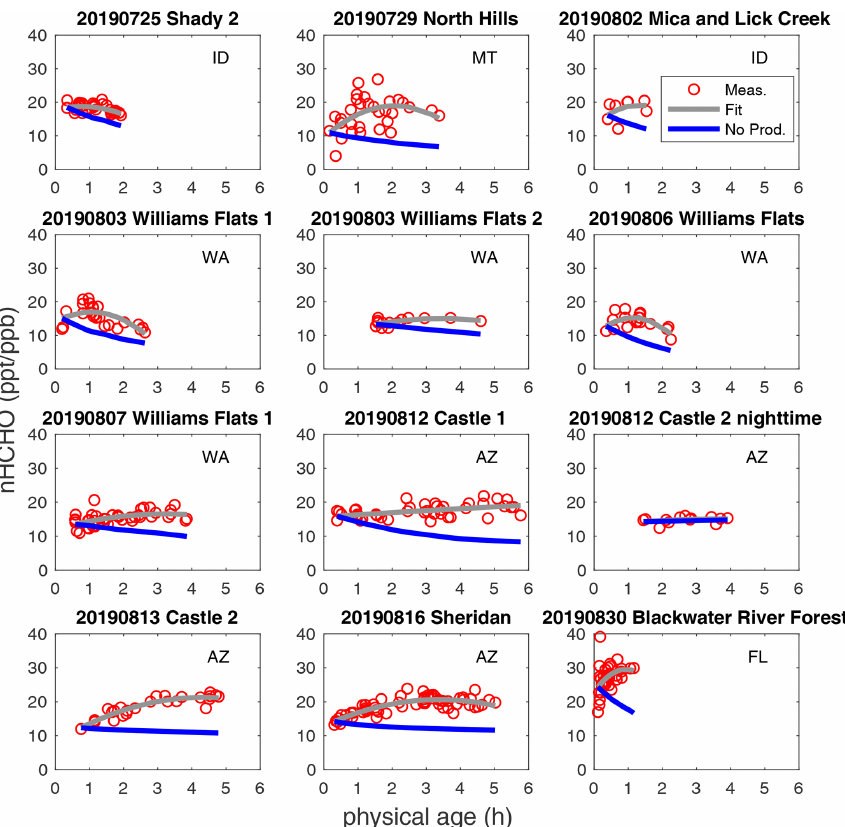
Figure 2. Observed nHCHO (HCHO to CO NEMR) trends (red circle), quadratic polynomial fit (pink curve), and calculated decay of nHCHO trend without secondary production (blue curve) using measured photolysis rates along plume physical age for the 12 wildfire plumes. The state of fire location for each fire plume is